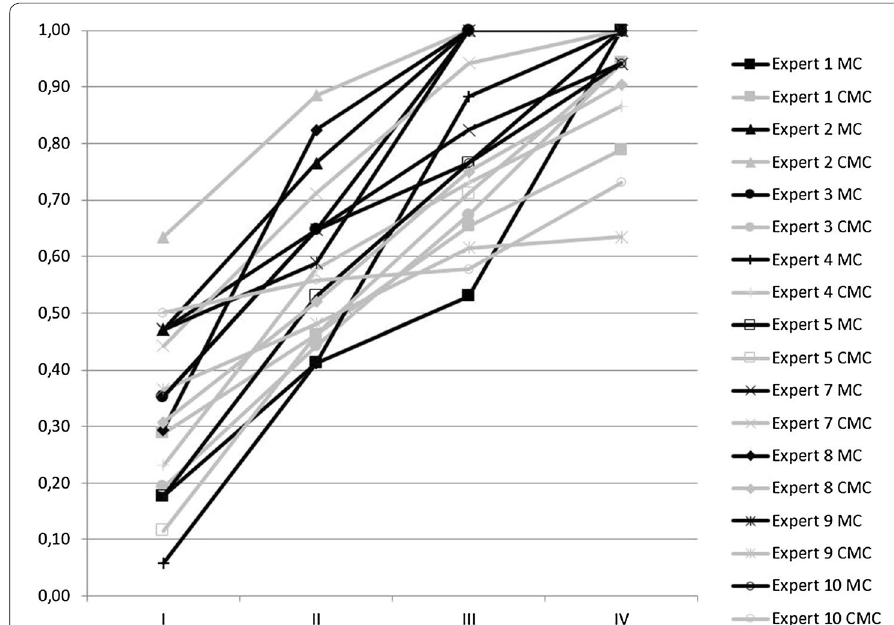
Fig. 3 Ratings of the experts for each cut score by Angoff method, round 1. Values of the same item format share the same color, values of the same expert share the same marker. Expert 6 did not show up at the workshop. MC multiple choice items, CMC complex multiple choice items